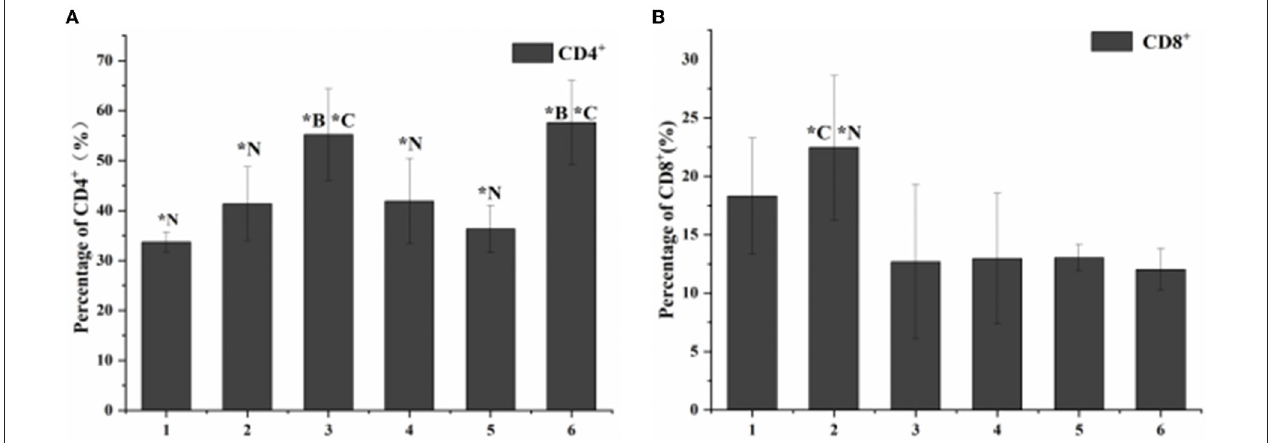
FIGURE 5 | Statistical chart of the proportion of lymphocyte subsets. 1. Blank control group. 2. Toxic group. 3. Penicillin G sodium treatment group. 4. Phage therapy group. 5. Combination therapy group. 6. Non-intervention group. The values are means and standard deviations (SD) ( n = 5). *C < 0.05. Each group vs. combination